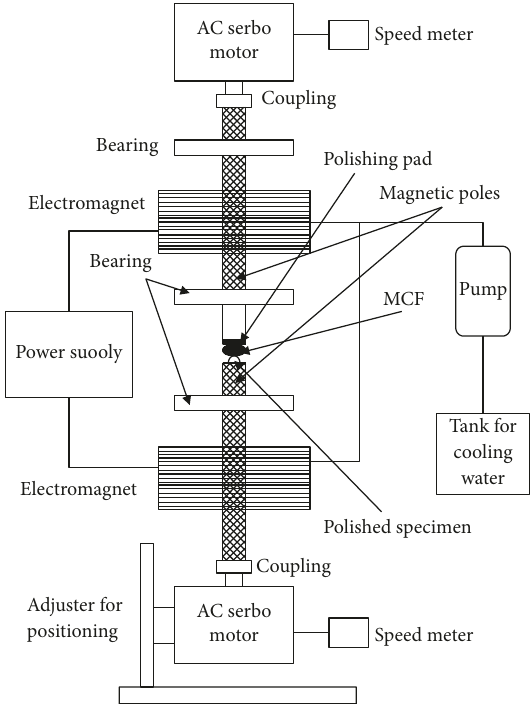
Figure 12: Schematic diagram of float polishing using MCF [68].